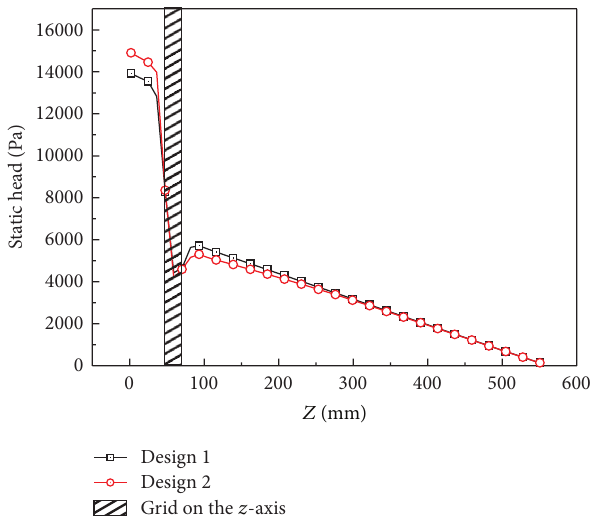
Figure 4: Pressure drop.